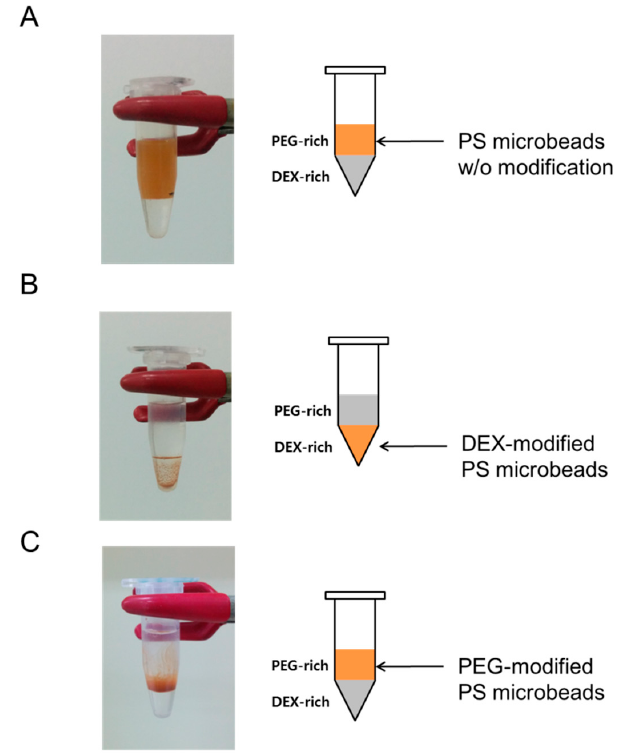
Figure 5. Cont. Figure 5.